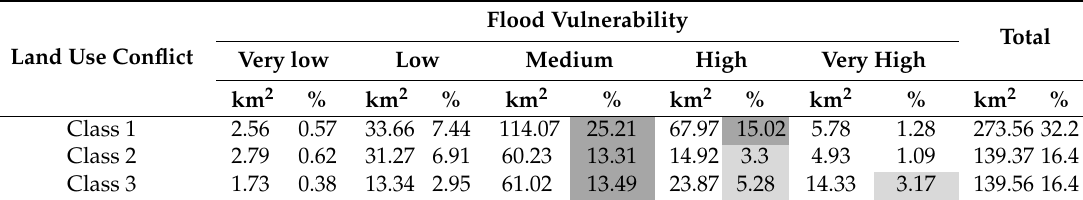
Table 6. Cross-classification of land use conflict and flood vulnerability in the municipality of Batatais SP. The grey shaded cells represent concern situations because they combine medium to very high flood vulnerability and land use conflict.